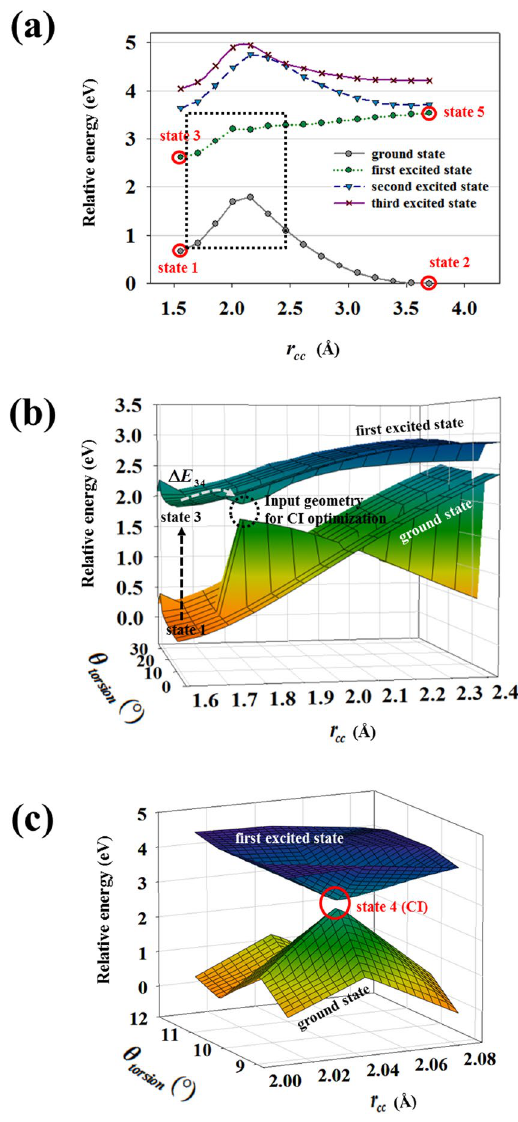
Figure 2. PESs of 1,2-bis(2-ethyl-5-phenyl-3-thienyl)perfluorocyclopentene. Highlighted red circles represent major molecular states. ( a ) Two-dimensional graph from geometry optimization and TD-DFT method is plotted for multiple energy states. Rectangular region with gray dotted line indicates the range of three- dimensional PES scanning. ( b ) Three dimensional PESs from geometry optimization and TD-DFT method containing the determined energy states from Fig. 2a. Δ E 34 is the cycloreversion activation energy on first excited PES. ( c ) PESs around the CI by CASSCF calculations based on the location of the CI vicinal region from Fig. 2b.